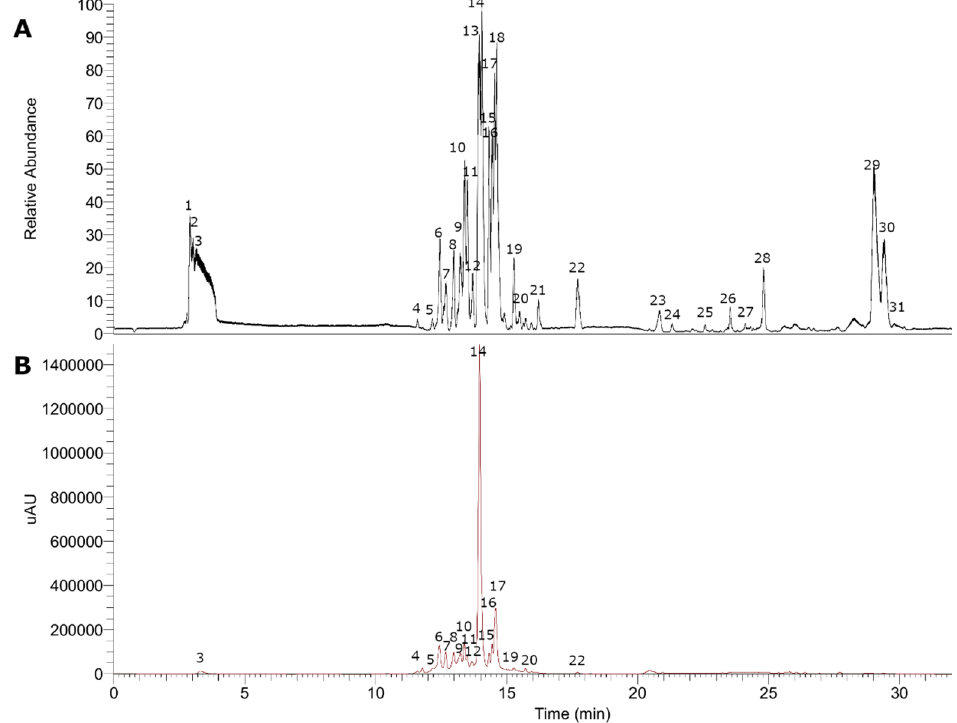
Figure 3. UHPLC chromatograms in the negative mode of Gaultheria pumila . ( A ) TIC chromato- gram. ( B ) UV at 280 nm.